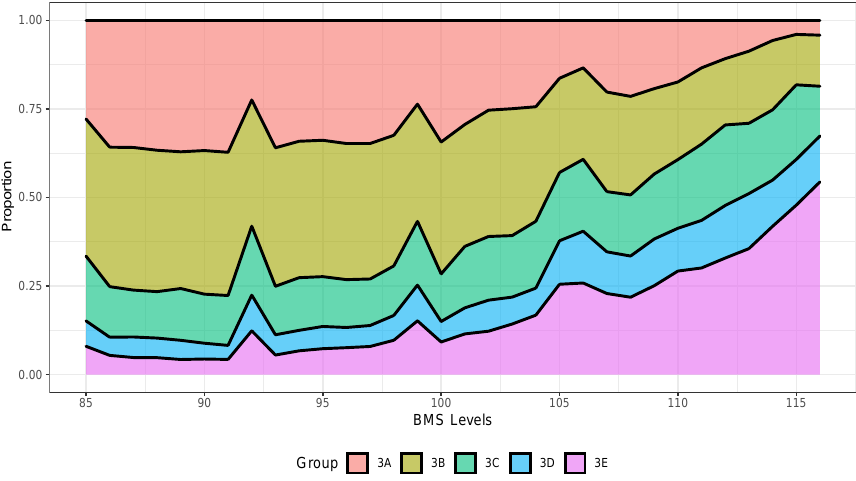
Figure 6. Proportion of each group within BMS levels for the BMS